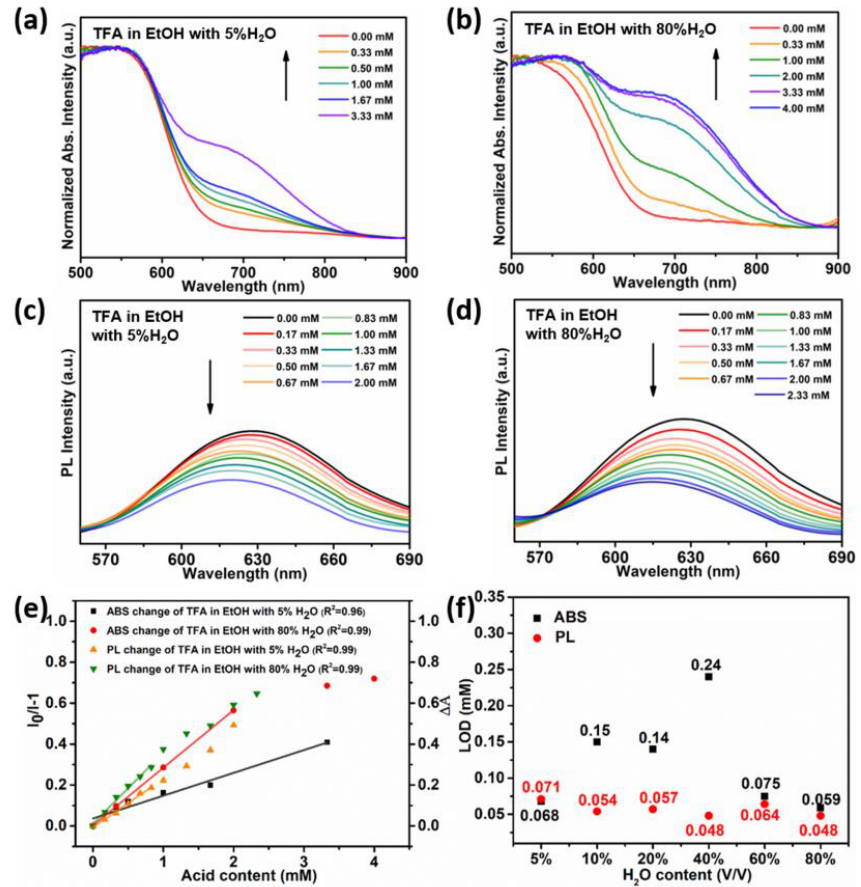
Figure 3. Solid-state absorption spectra of TPBD-TA COF in EtOH solutions of TFA with ( a ) 5% water, ( b ) 80% water ( V/V ) and different acid concentration, fluorescence spectra of TPBD-TA COF in TFA EtOH solution with ( c ) 5% water, ( d ) 80% water ( V/V ) and different acid concentration, ( e ) the linear relationship between acid content and emission ratios/or absorption change, ( f ) the LOD values of detecting TFA in EtOH solutions with different amount of water.